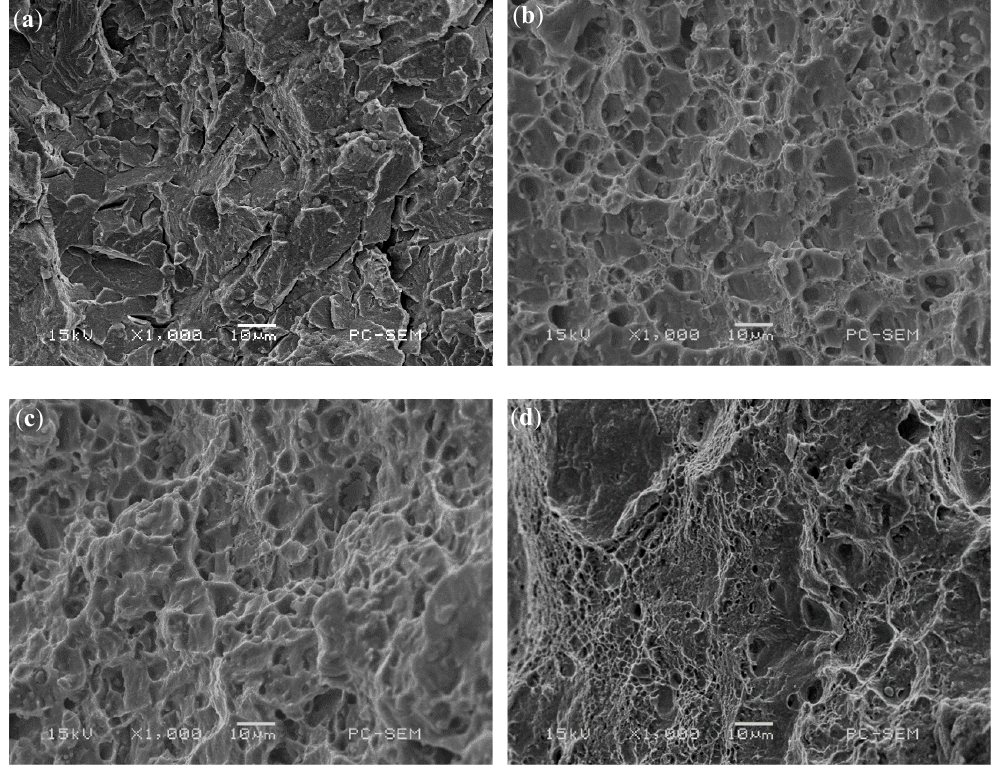
Figure 10. Impact fracture morphologies of Coatings with different CeO 2 content: ( a ) 0.0% CeO 2 , ( b ) 1.0% CeO 2 , ( c ) 1.5% CeO 2 , and ( d ) 2.0% CeO 2 .